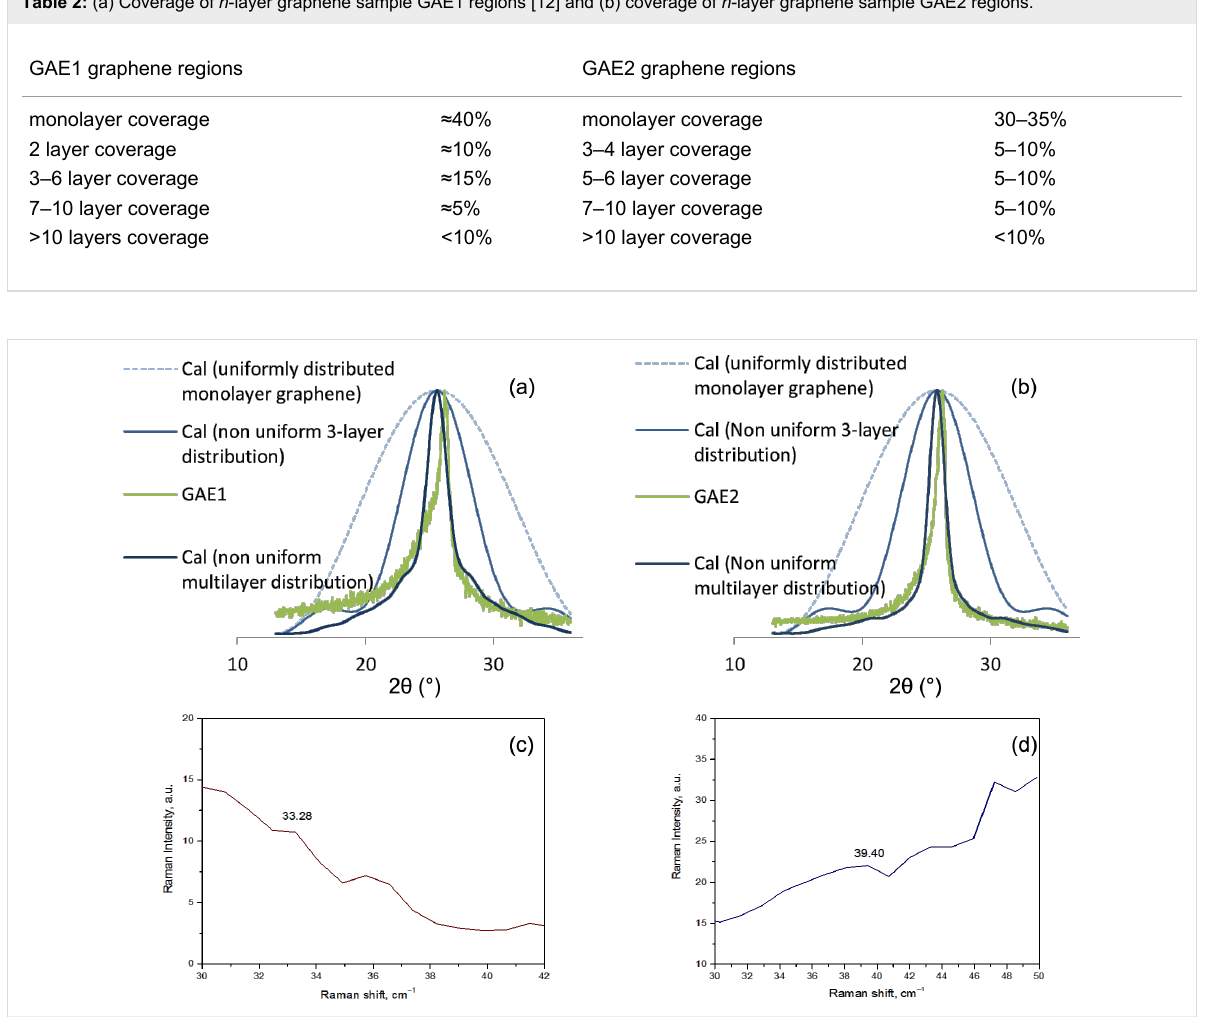
Table 2: (a) Coverage of n -layer graphene sample GAE1 regions [12] and (b) coverage of n -layer graphene sample GAE2 regions.